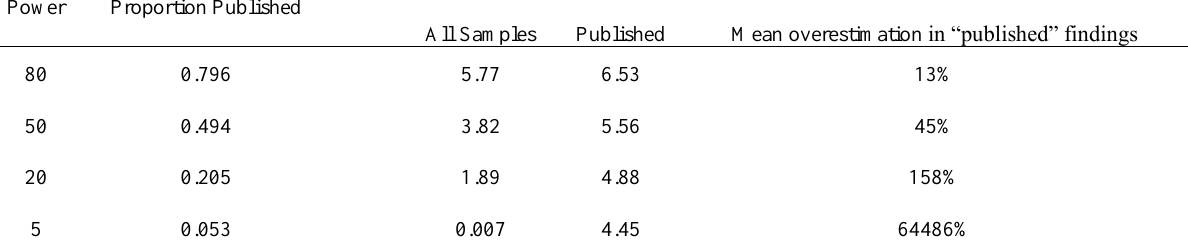
The Results of 40,000 Simulated Comparative Cognition Studies by